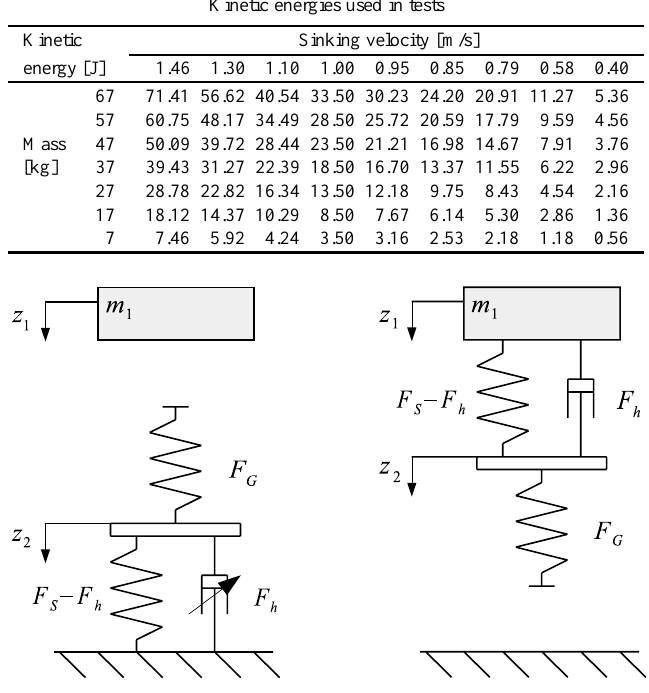
Table 4 Kinetic energies used in tests